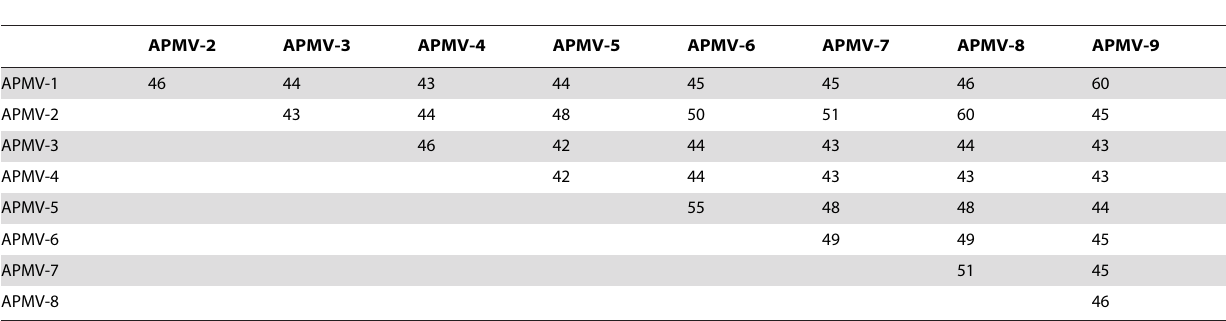
Table 1. Percent nucleotide sequence identities between the complete genomes of prototype strains of the nine APMV serotypes.